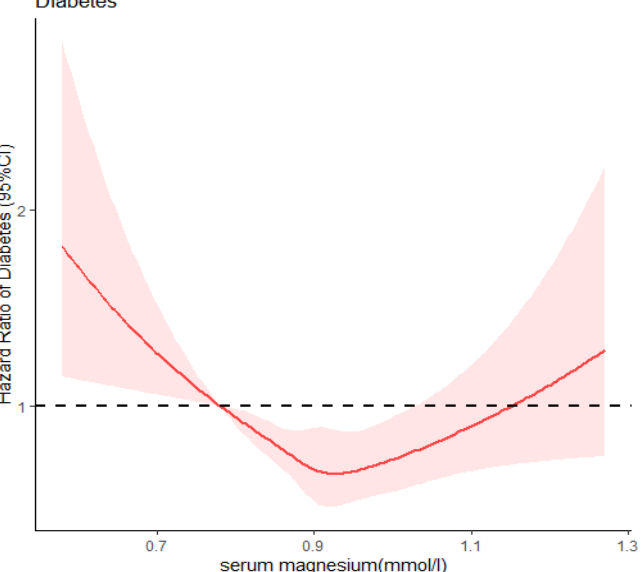
Figure 2. Restricted cubic spline of association between serum magnesium and Type 2 diabetes.